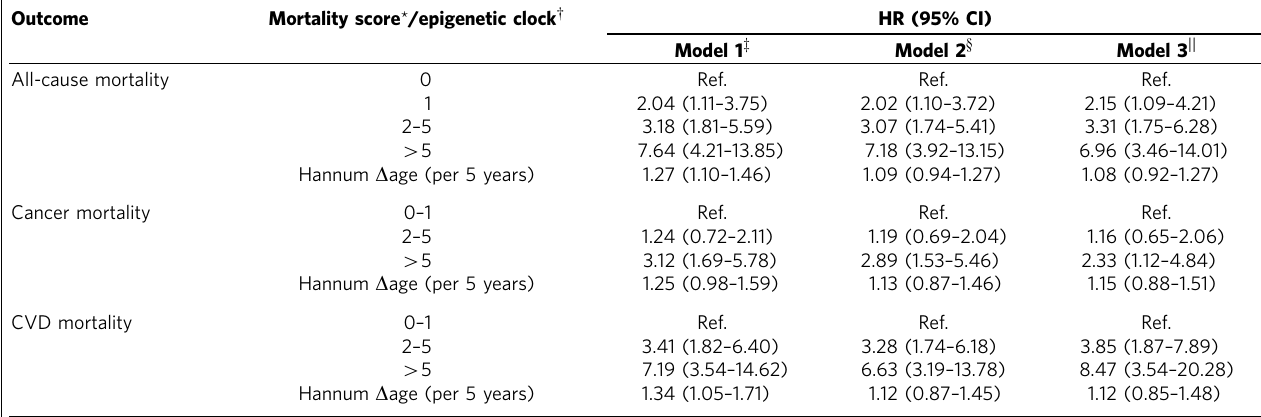
Table 5 | Associations of the risk score and epigenetic clock with all-cause and cause-specific mortality in the ESTHER